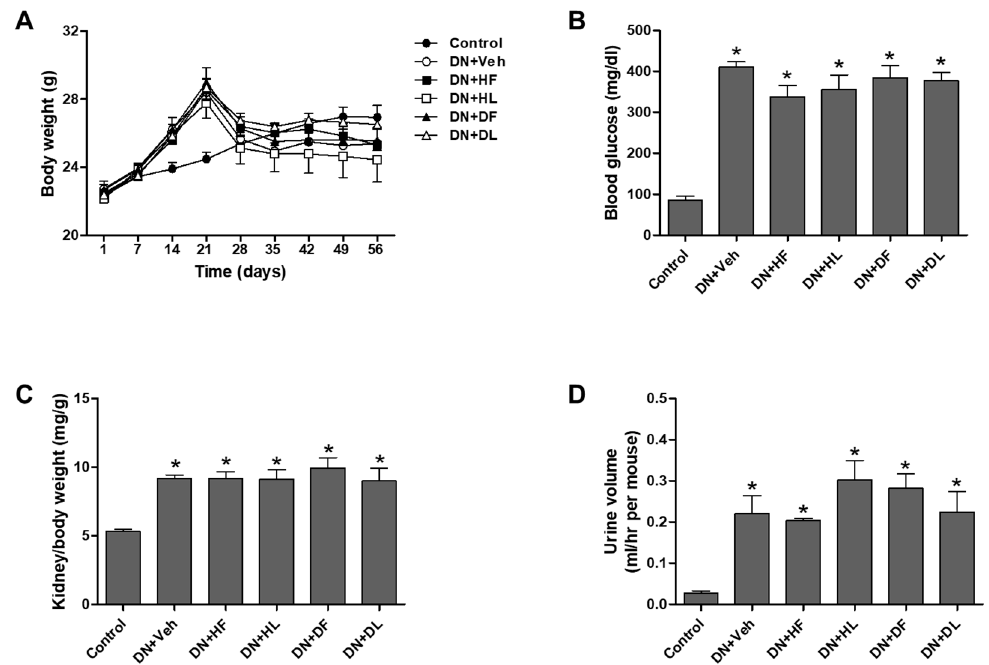
Figure A1. Effect of AM extracts on body metabolic parameters of DN mice: body weight ( A ), fasting blood glucose ( B ), kidney-to-body weight ratio ( C ), and urine volume ( D ). The data are presented as the mean ± SEM. * p < 0.05 versus control group, # p < 0.05 versus DN+Veh group.